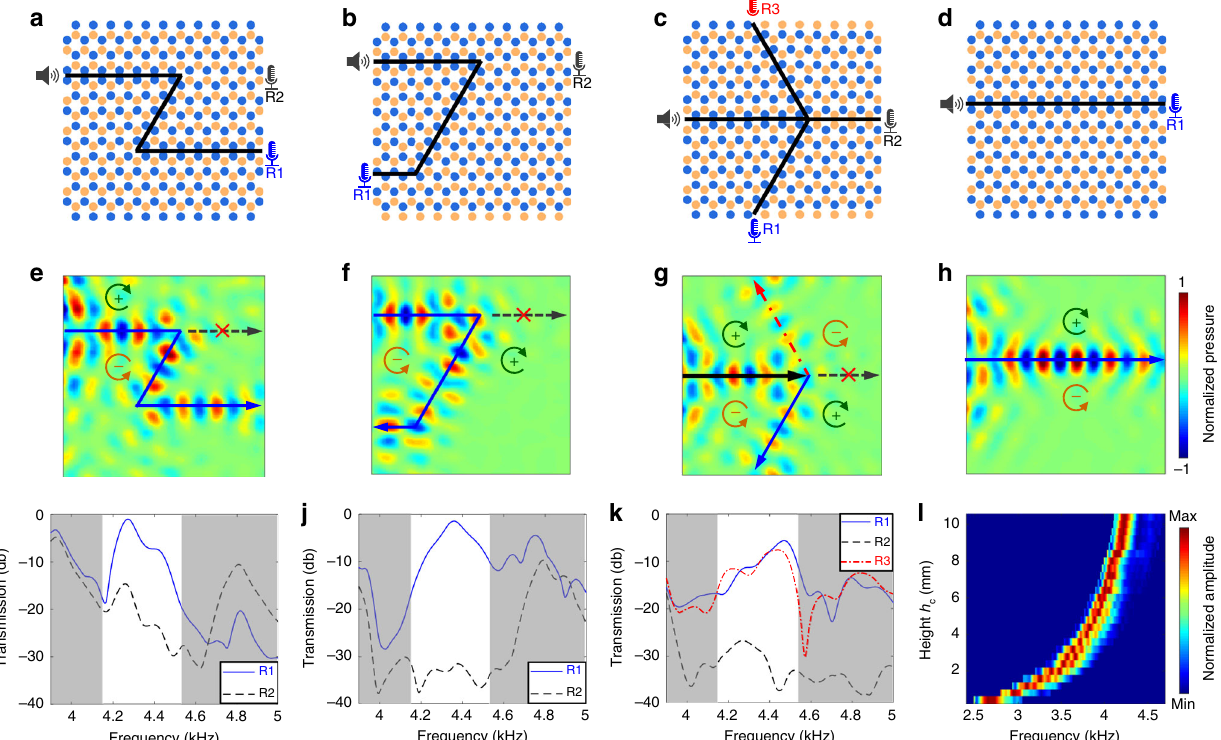
Fig. 3 Experimental results for controlling the edge mode of waveguide acoustic waves. Valley phononic crystals with different interface con fi gurations for a transporting acoustic waves along a Z-shaped path, b 180 degrees turning of acoustic waves, c dividing acoustic waves with a four-port topological junction, and d guiding acoustic waves along a straight path. The blue and brown circles represent cavities with depths of 10 and 13mm, respectively. e – h Experimental pressure fi elds at 4.3kHz for con fi gurations in a – d , respectively. The circulation arrows represent directions of pseudospins. i – k Experimental transmission spectra for con fi gurations in a – c , respectively. The shadow regions correspond to bulk bands. l Two-dimensional (2D) representation of normalized amplitudes versus frequency and channel height h c for transmitted edge waves through the straight interface in d . The 2D representation shows that the frequencies of transmitted edge waves gradually increase from 2.6 to 4.3kHz with the increase of channel height h c from 0.4 to